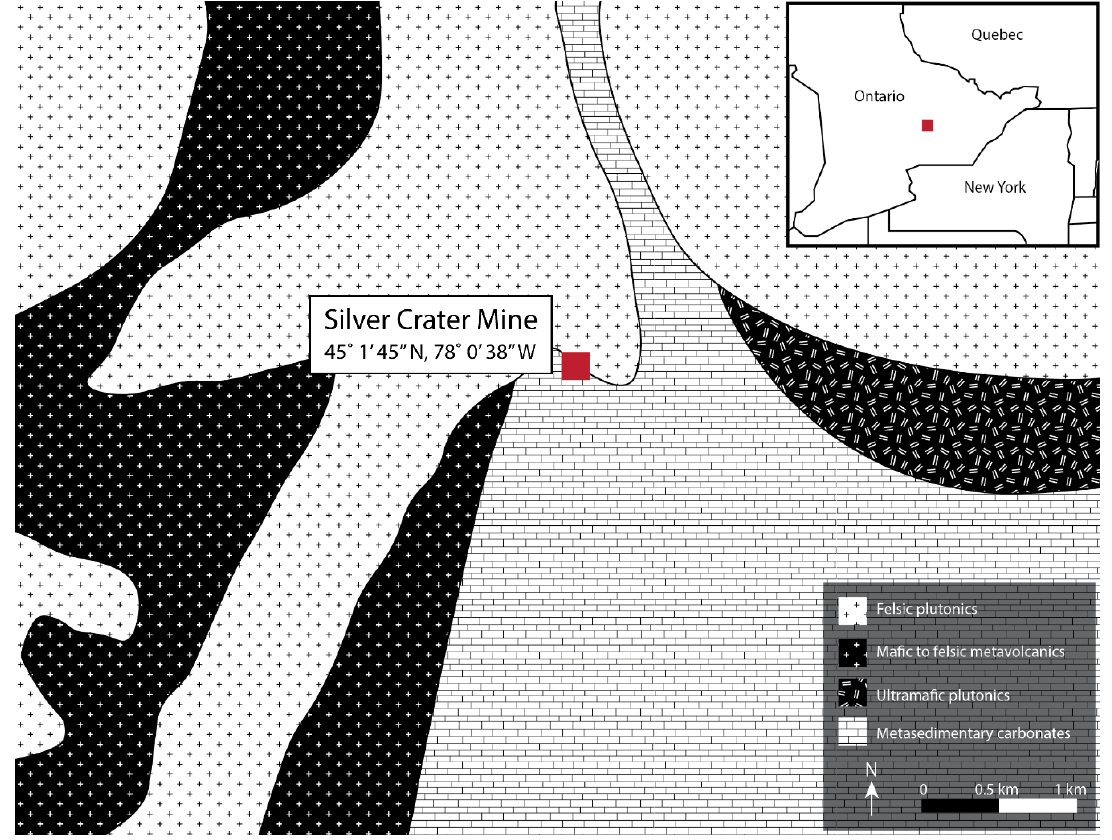
Figure 1. Geologic map of the bedrock adjacent to the Silver Crater Mine (red square) with an inset showing the mine’s location in southeastern Ontario. Created using geological map data from Ontario Geological Survey Miscellaneous Release — Data 126 Revised [24].